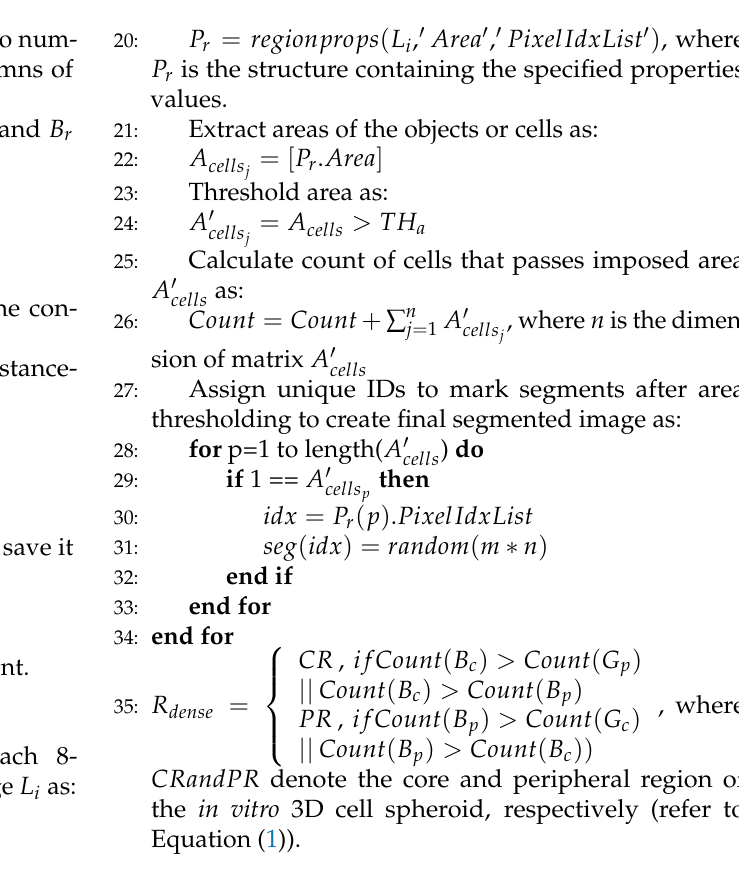
Algorithm 1 Region-estimation